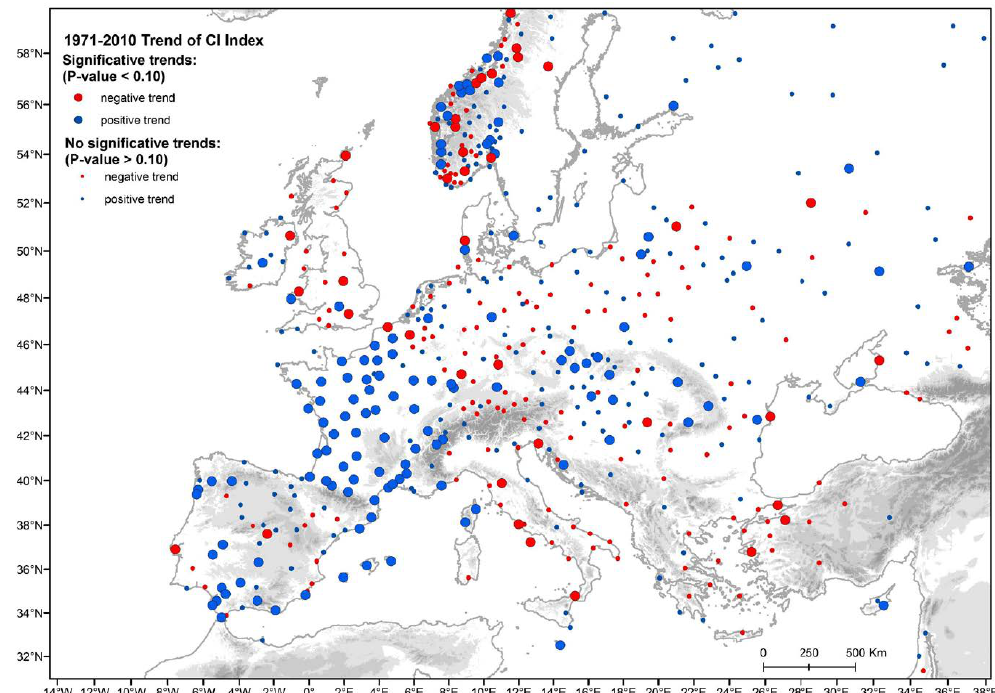
Fig. 8. Annual CI trend distribution (1971–2010). Positive trends are in blue and negative ones in red. Large dots represent significative trends ( p < 0 . 10), otherwise small dots are